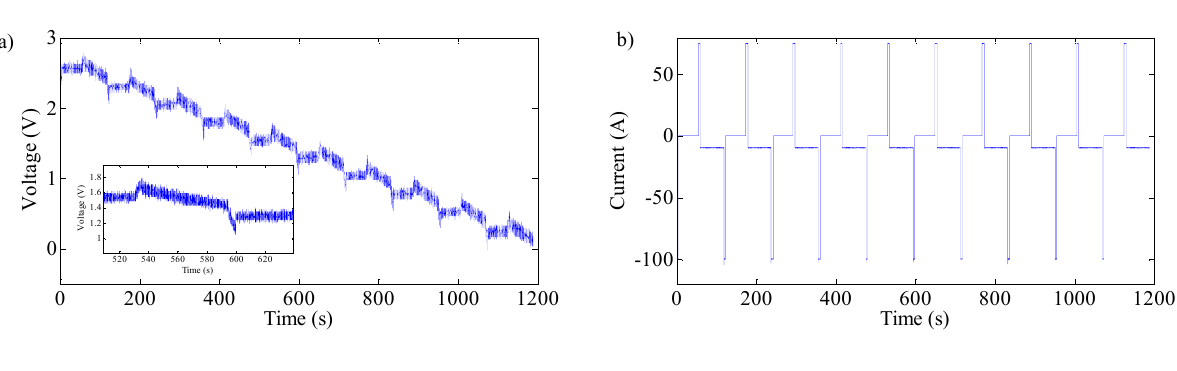
Figure 9. The simulated and measured voltages in the HPPC test.